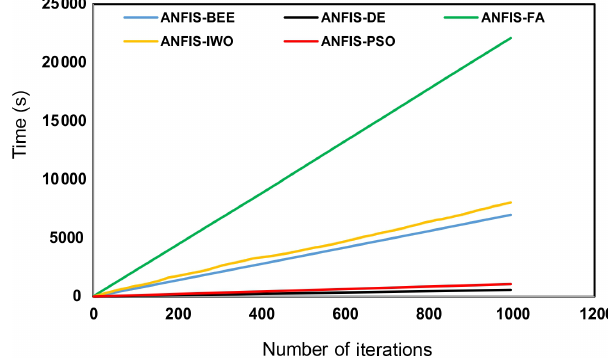
Figure 7. Processing time used for training the five models.